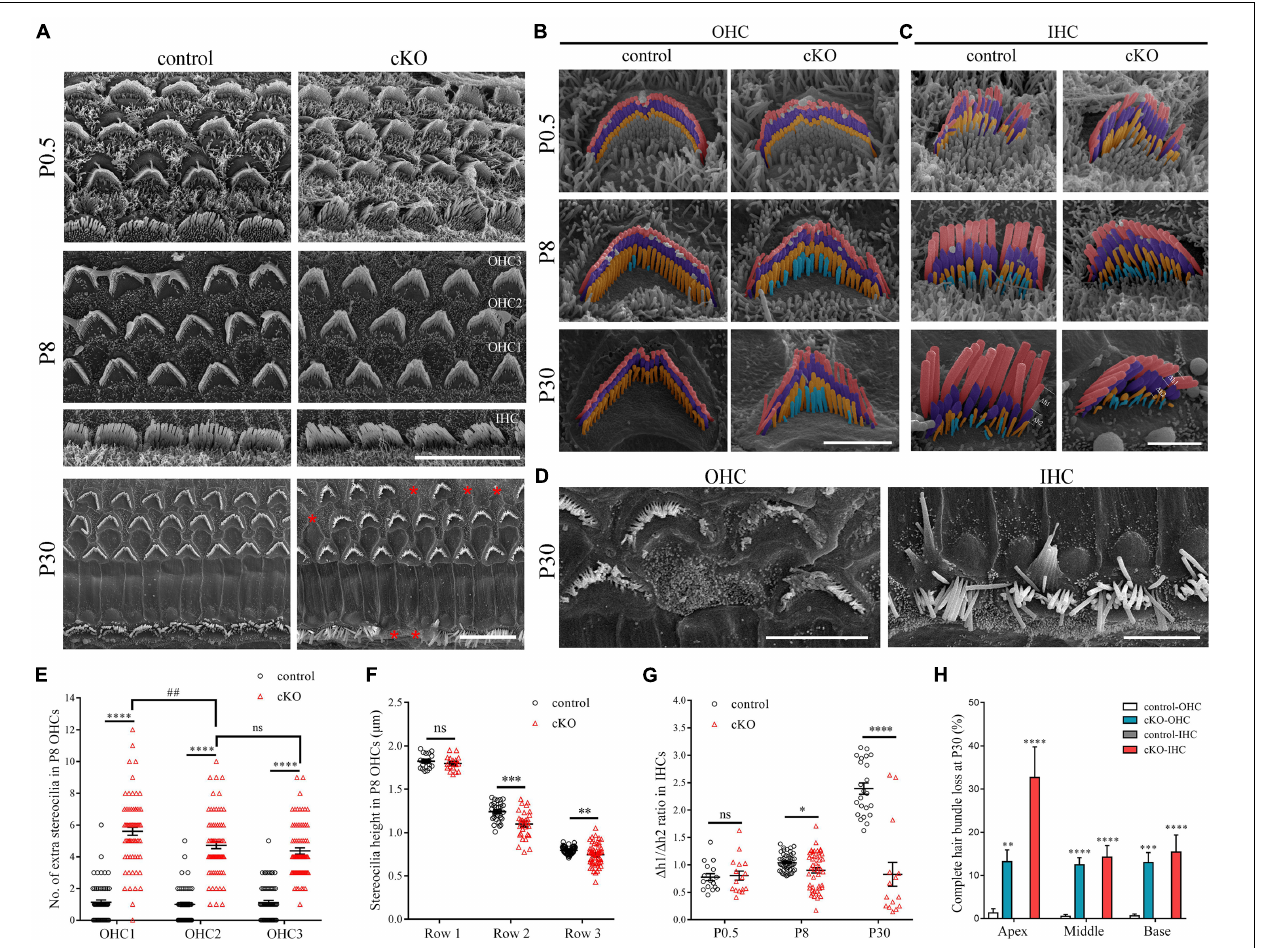
FIGURE 1 | Hair cell-specific Cdc42 inactivation leads to stereocilia development deficits. (A) Low magnification SEM images of the hair bundles from control or cKO mice at different ages as indicated. Shown are images taken from the middle turns. Asterisks indicate complete loss of hair bundles. Scale bar: 10 µ m. (B,C) High magnification pseudo-colored SEM images of hair bundles from control or cKO OHCs (B) and IHCs (C) at different ages as indicated. The first, second, and third row stereocilia are indicated by pink, purple, and yellow, respectively. The extra fourth-row stereocilia are indicated by cyan. (cid:49) h1 and (cid:49) h2 represent the relative distance from 1st row stereocilium tip to its parallel connecting 2nd row stereocilium tip and the 2nd row stereocilium tip to its parallel connecting 3rd row stereocilium tip, respectively. Shown are images taken from the middle turns. Scale bars: 2 µ m. (D) High magnification SEM images of severely disorganized hair bundles from control or cKO mice at P30. Shown are images taken from the middle turns. Scale bar: 5 µ m. (E) Number of the extra fourth-row stereocilia per P8 OHC was analyzed according to the results from (B) . (F) Average stereocilia height in different rows of P8 OHCs were analyzed according to the results from (B) . (G) The (cid:49) h1/ (cid:49) h2 ratio in IHCs at different ages was analyzed according to the results from (C) . (H) Percentage of P30 OHCs and IHCs with complete hair bundle loss was calculated according to the results from (A) . For statistical analyses in (E–H) , images were randomly taken from at least three animals for each group. The bars indicate mean ± SEM values. ∗ P < 0.05; ∗∗ P < 0.01; ∗∗∗ P < 0.001; ∗∗∗∗ P < 0.0001; ## P < 0.01; ns, no significant difference.